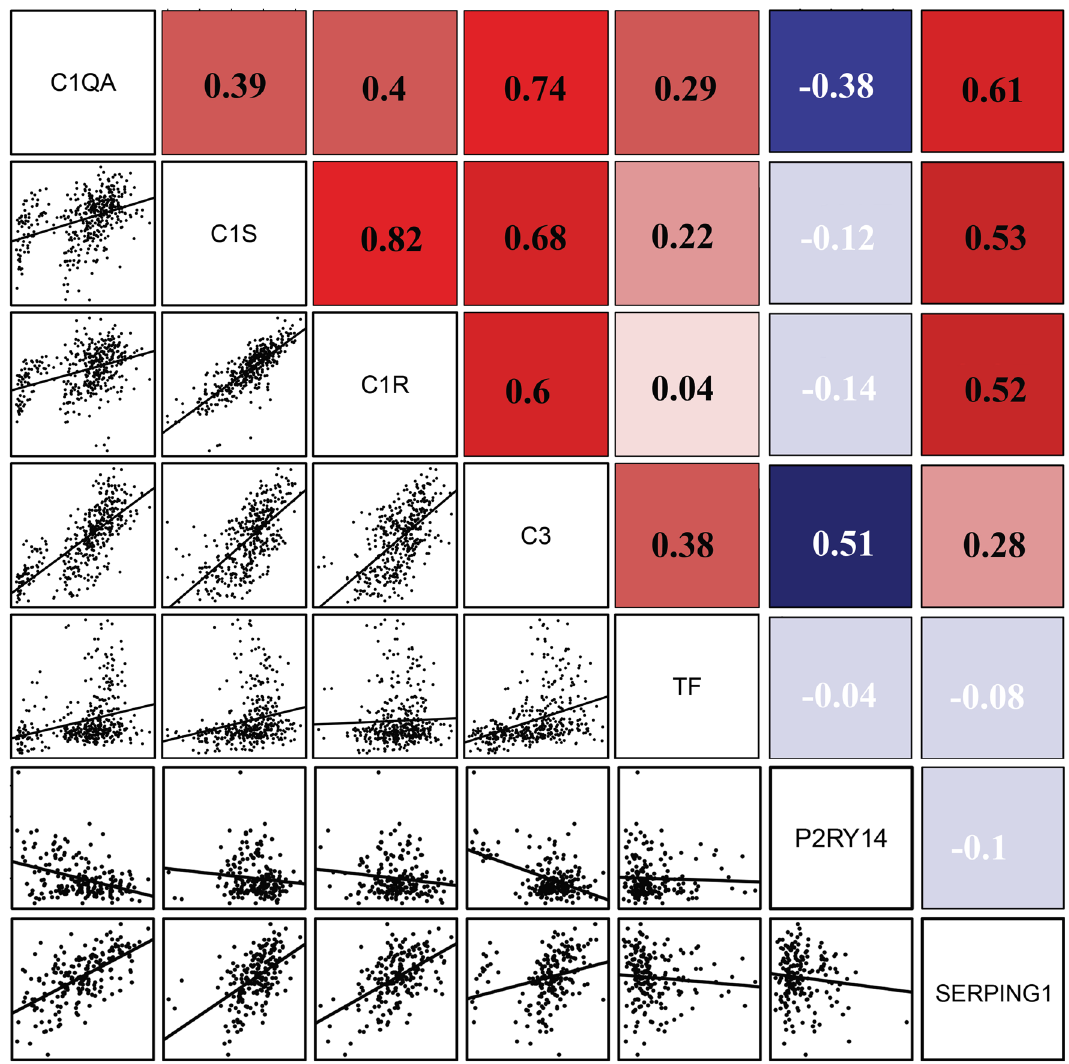
Figure 8. Gene co-expression correlation analysis. The expression of central complement factors was positively related to TF while SERPING1 and P2RY14 were negatively related to TF. Red represents a positive correlation and blue indicates a negative